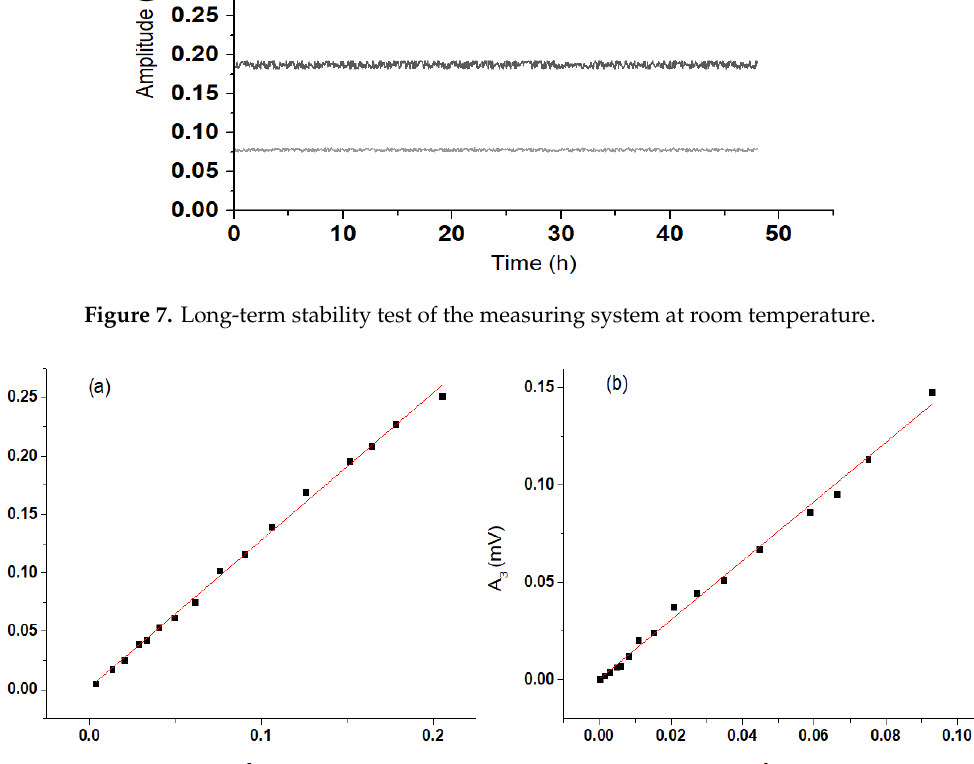
Figure 8. Linearity assessment of the measuring system for ( a ) Second Harmonic and ( b ) Third Harmonic.